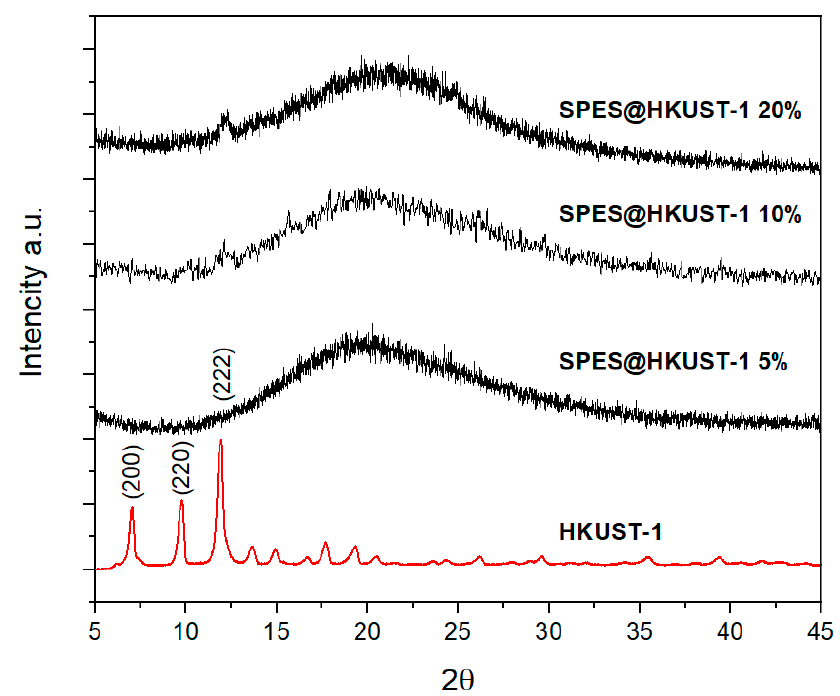
Figure 1. Powder X-ray diffraction of the SPES@HKUST-1 membranes with different amount of HKUST-1 (5, 10, and 20%) and the pristine MOF HKUST-1.